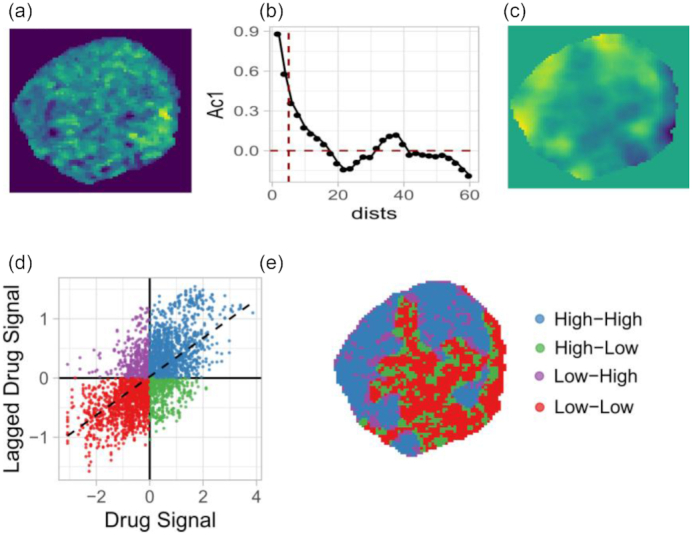
Schematic workflow of drug LISA map creation. (a) Original drug ion image. (b) Spatial correlogram of the drug-ion image, where Moran I values (Ac1) are plotted against the lag distance (dists). (c) Spatially lagged image of the drug-ion. (d) Moran I scatter plot, where the drug signal and its spatially lagged version are regressed against each other. (e) LISA clustered map of the drug ion where pixels falling in the same quadrant of the Moran scatter plot are grouped.